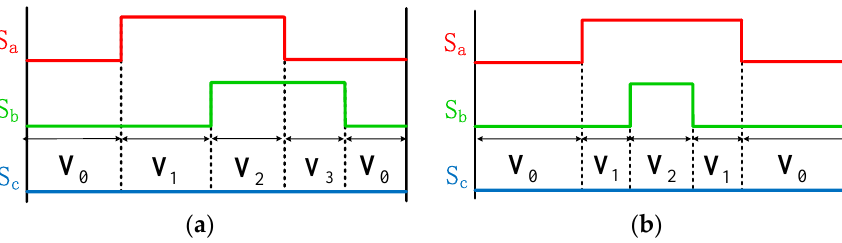
Figure 6. Operation sequences of switches and voltage-space-vectors variation. ( a ) voltage-space-vectors operation without phase regulation; ( b ) optimal voltage space vector (OVSV) operation with phase regulation.